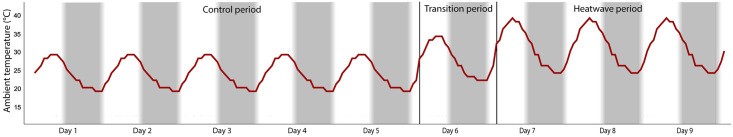
Photoperiod and temperature profile used to simulate control, transition, and heat wave temperatures.The white areas represent day time and shaded areas represent night time. The black lines represent changes in experimental condition, with the control temperatures lasted 5 days, transition temperatures lasted 1 day and the simulated heat wave lasted 3 days. The red line represents the temperature cycle that animals were exposed to during the 9-day experiment.